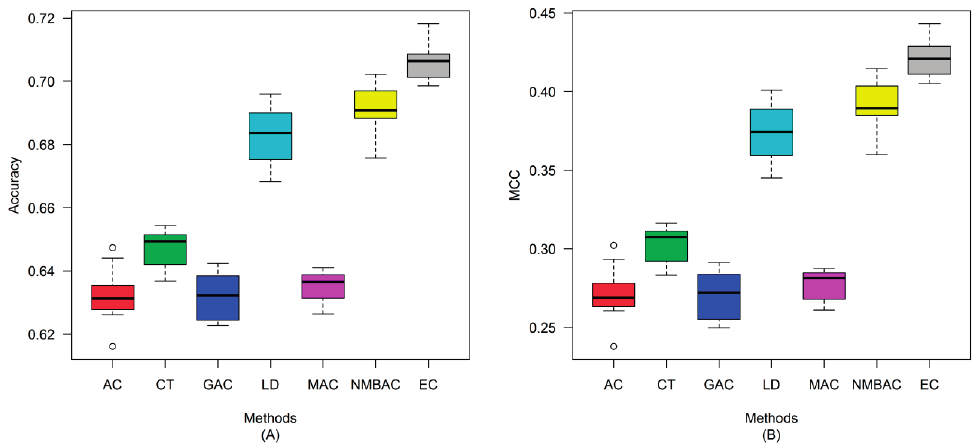
Figure 7. Average accuracy and MCC of different methods on the Gold Yeast dataset with five-fold cross-validation. ( A ) Accuracy; ( B ) MCC.